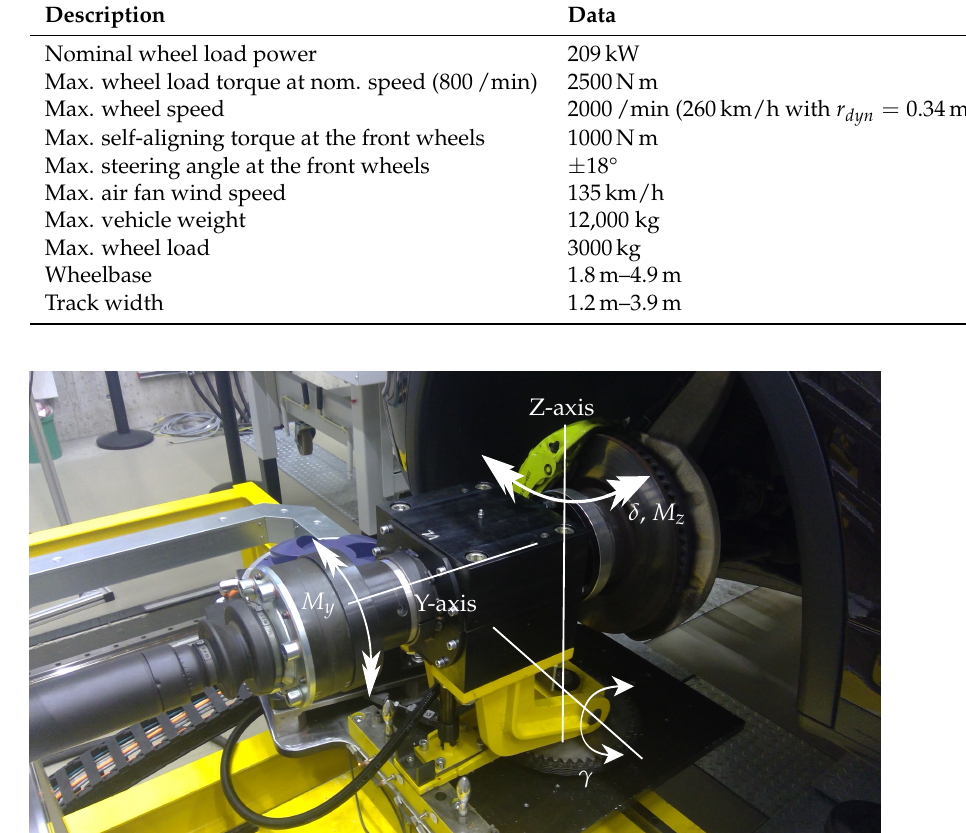
Figure 3. Rotatable wheel adapter units for transmitting wheel speeds, wheel torque M y and self- aligning torque M z with variable steering angles δ and chassis geometries (camber angle γ